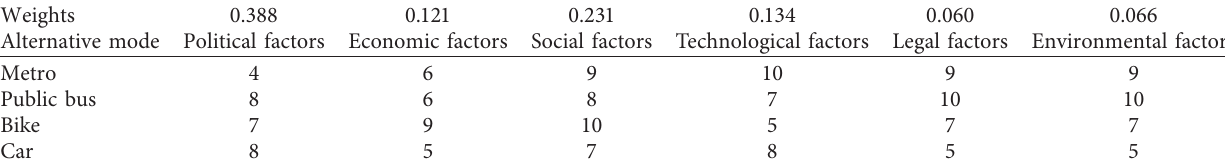
Table 6: Criterion- alternative evaluation matrix.